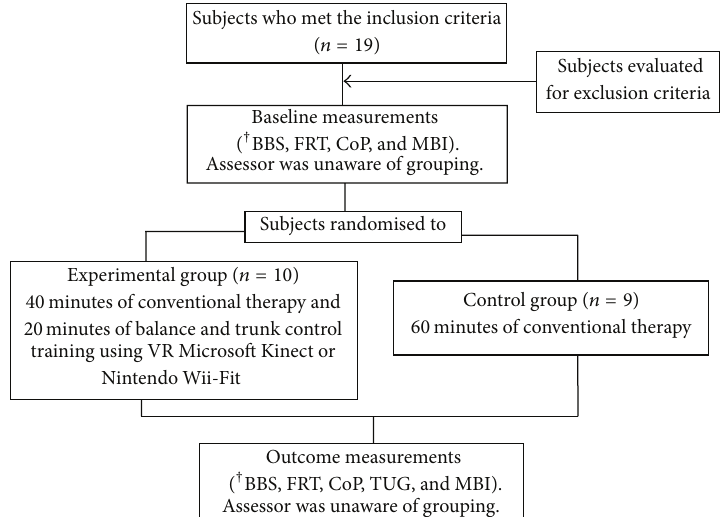
Figure 3: Flow chart of the experiment procedure. † BBS = Berg Balance Scale, FRT = Functional Reach Test, CoP = Centre of Pressure using Nintendo Wii-Fit, TUG = Timed Up and Go, MBI = Modified Barthel